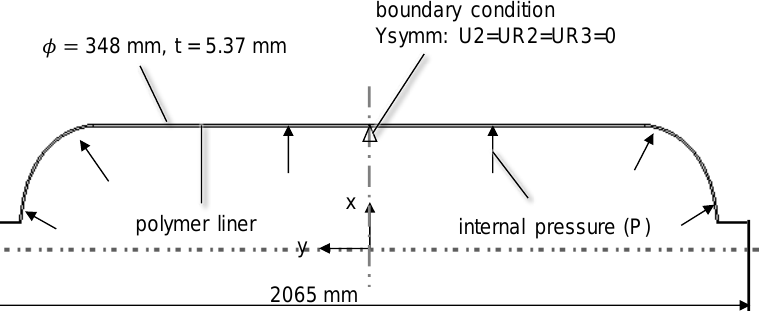
Figure 6. Boundary and loading conditions for the finite element